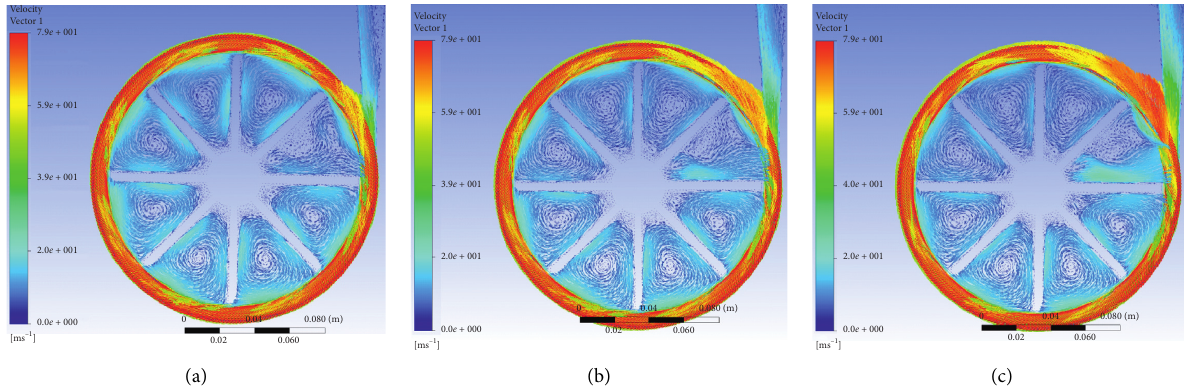
Figure 8: The vector distribution with inducer at different flow rates (a) Q